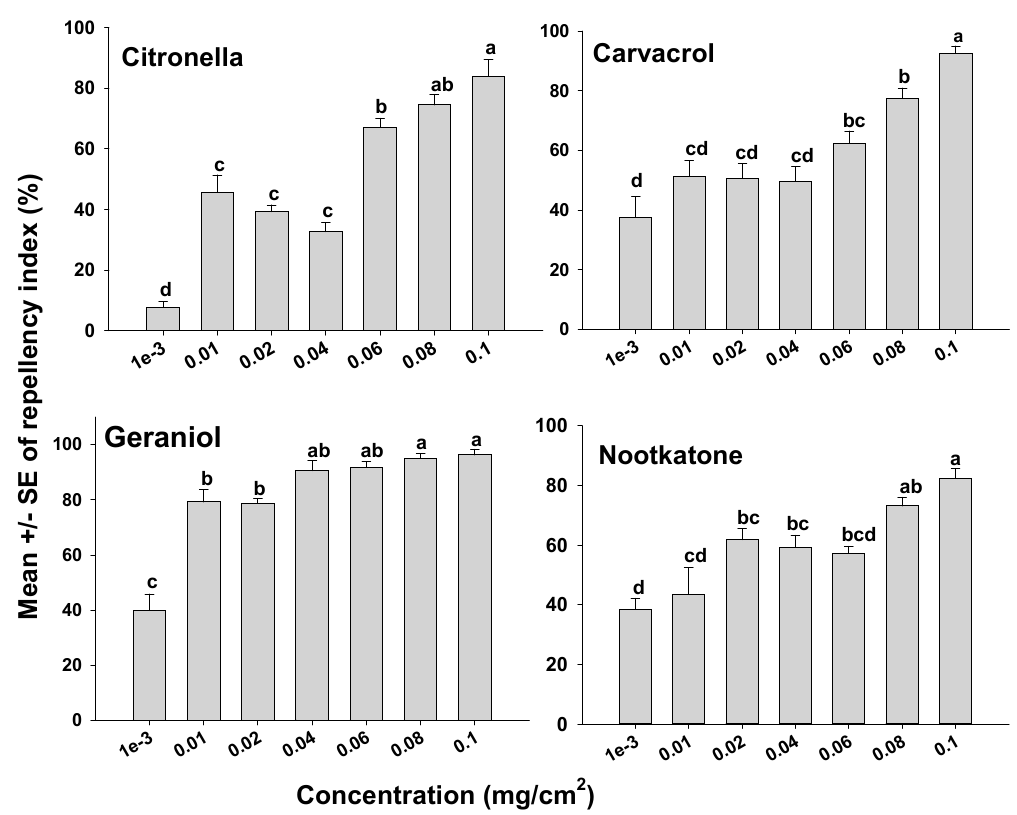
Figure 1. Orientation response of T. putrescentiae on glass surfaces treated with terpenes in a laboratory two-choice behavioral assay. ANOVA determined that there was significant variation among concentrations for each of the terpenes tested (F-value range 1.27–49.92; p -value < 0.001). Mean RIs ( ± SE; n = 5) for a given terpene with the same letter are not significantly different (REGWQ; p > 0.05).